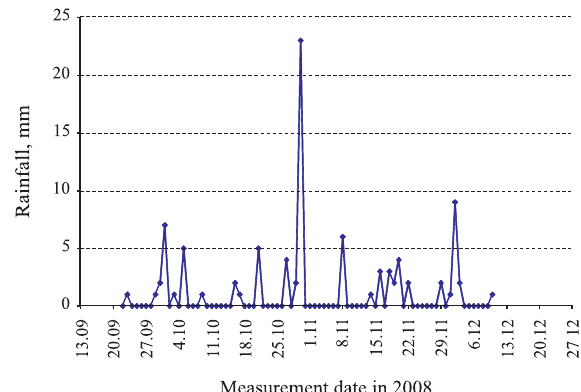
Fig. 5. Average daily precipitation on the plant site in the AMP Benninghoven in 2008